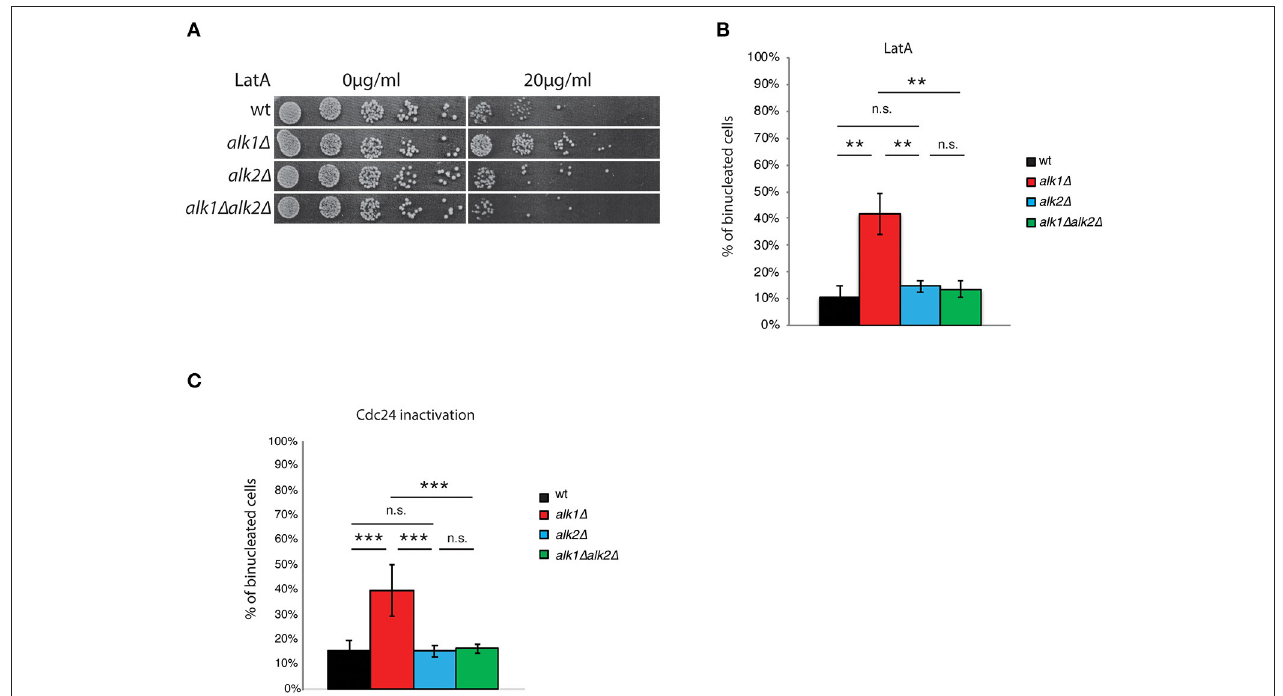
FIGURE 1 | Haspin mutants show altered response to polarity failures. (A) Serial dilutions of cultures of the indicated strains were spotted on either DMSO or LatA containing plates. After 24h incubation at 28 ◦ C plates were imaged. (B) Cells of the indicated strains expressing Tub1-GFP were arrested in G1 with mating pheromone and then released in the presence of 100 µ M LatA. After 4h cells were fixed and analyzed for nuclear division by fluorescence microscopy. (C) Cells were arrested in G1 at the permissive temperature (25 ◦ C), shifted for 45’ at the restrictive temperature (37 ◦ C) and then released at 37 ◦ C. After 2h, samples were fixed and analyzed for nuclear division, as above. Error bars in (B,C) represent standard deviation, statistical significance was measured by T -test, ns: not significant, ** p < 0.01, *** p <